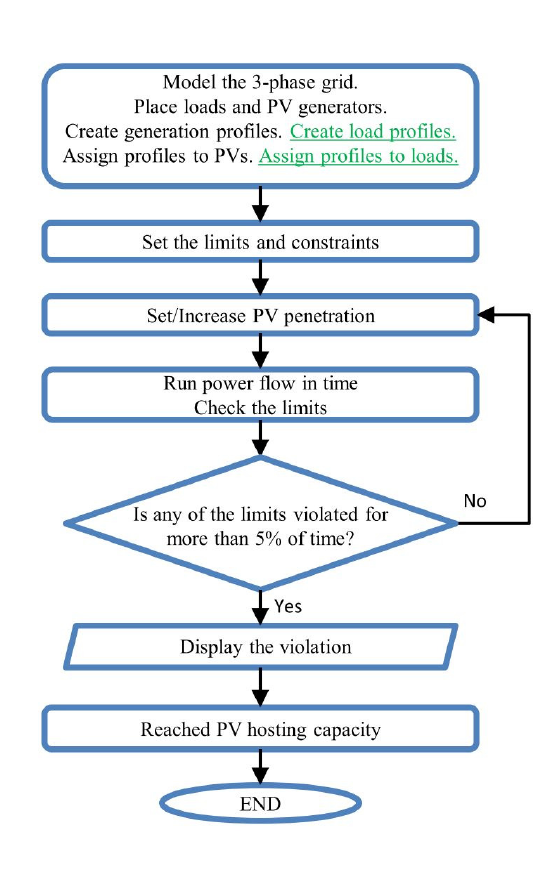
Figure 2. Flow chart of the algorithm to assess hosting capacity for system with PVs and loads (time-variable and